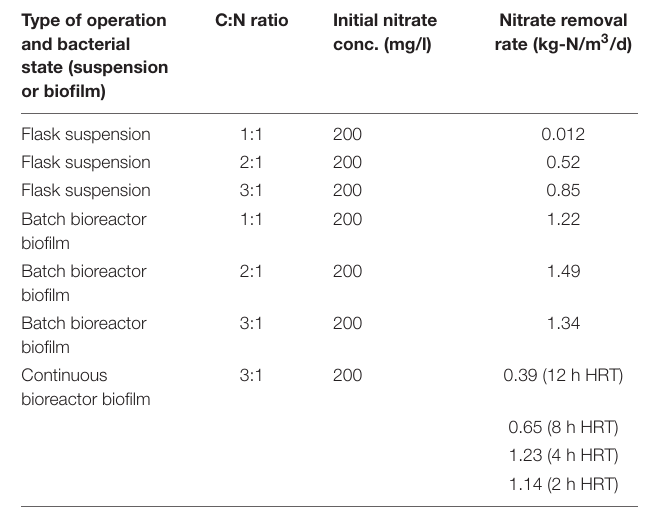
TABLE 3 | Summary of the different experiments and their main results.